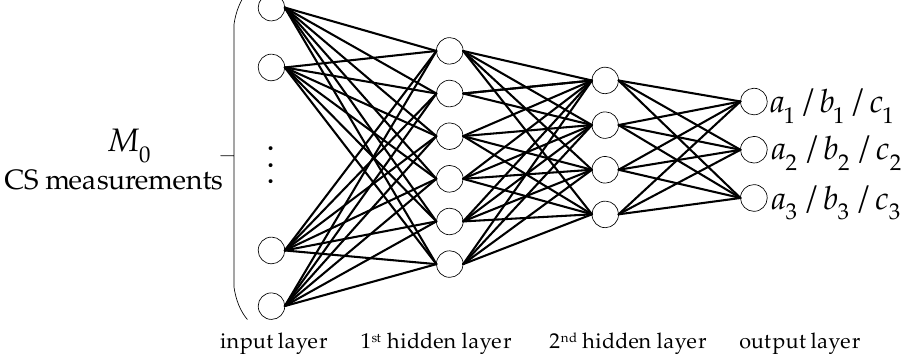
Figure 5. The neural network structure of predicting model parameters.